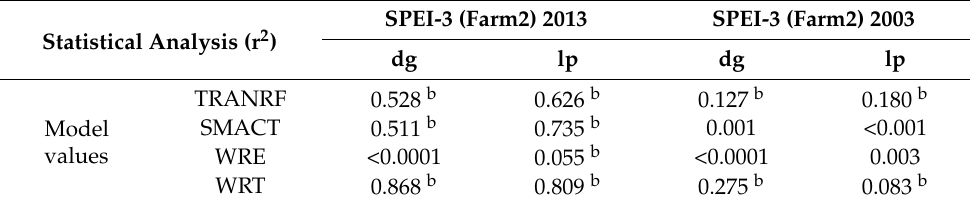
Table 4. Statistical analysis of drought index SPEI-3 at Farm2 and the LINGRA-N model results of yield (TRANRF, SMACT, WRE, WRT) for years 2013 and 2003—shown are values of r 2